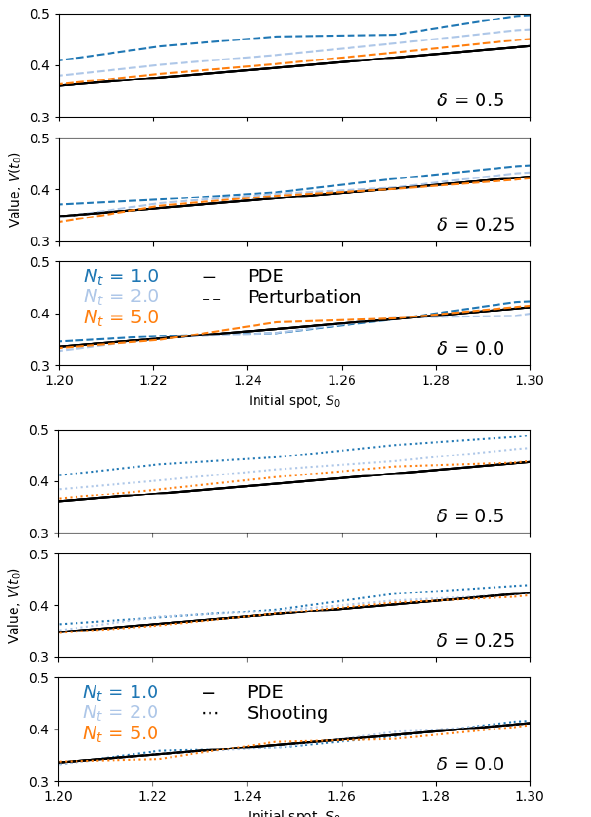
Figure 1. The value as a function of the initial spot as calculated using the perturbation and shooting methods for different dividend rates, δ , and number of updates of the intrinsic value, N t . The calcu- lated values are compared to numerically exact values calculated by the PDE. The PDE is calculated on a grid with 10 2 spot and 10 3 time points. The intrinsic value methods are calculated with 10 4 Monte–Carlo paths that have 10 2 time points. The inner and outer iterations are stopped after 5 iterations.